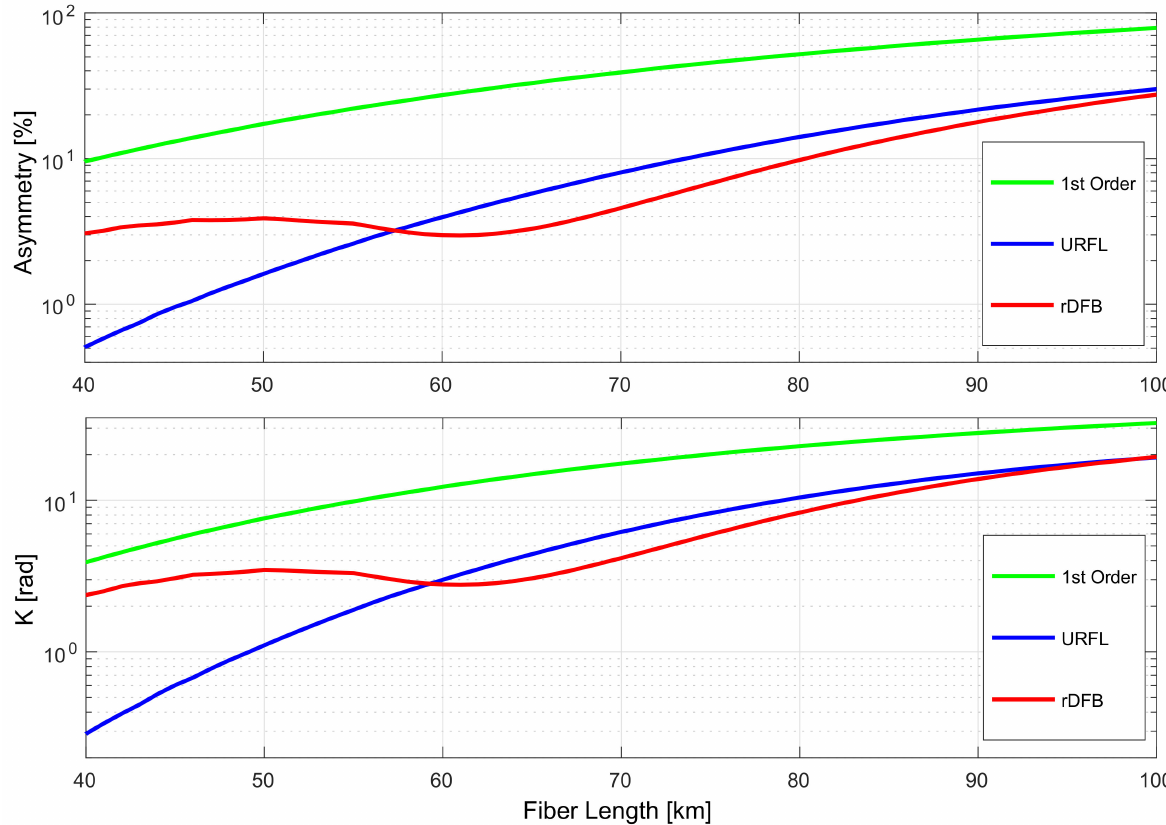
Figure 10. Lowest signal power asymmetry for a given length with pump powers adjusted to give zero net gain ( top ) and the accumulated residual phase shift ( bottom ) for a given amplifica- tion